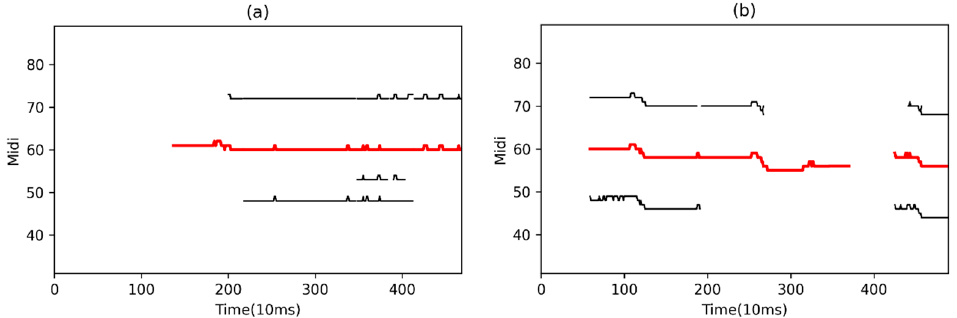
Figure 4. Salience graphs after average energy contour filtering. Red lines are the melody contours: ( a ) ADC04.daisy01.wav, ( b ) ADC04.daisy02.wav.